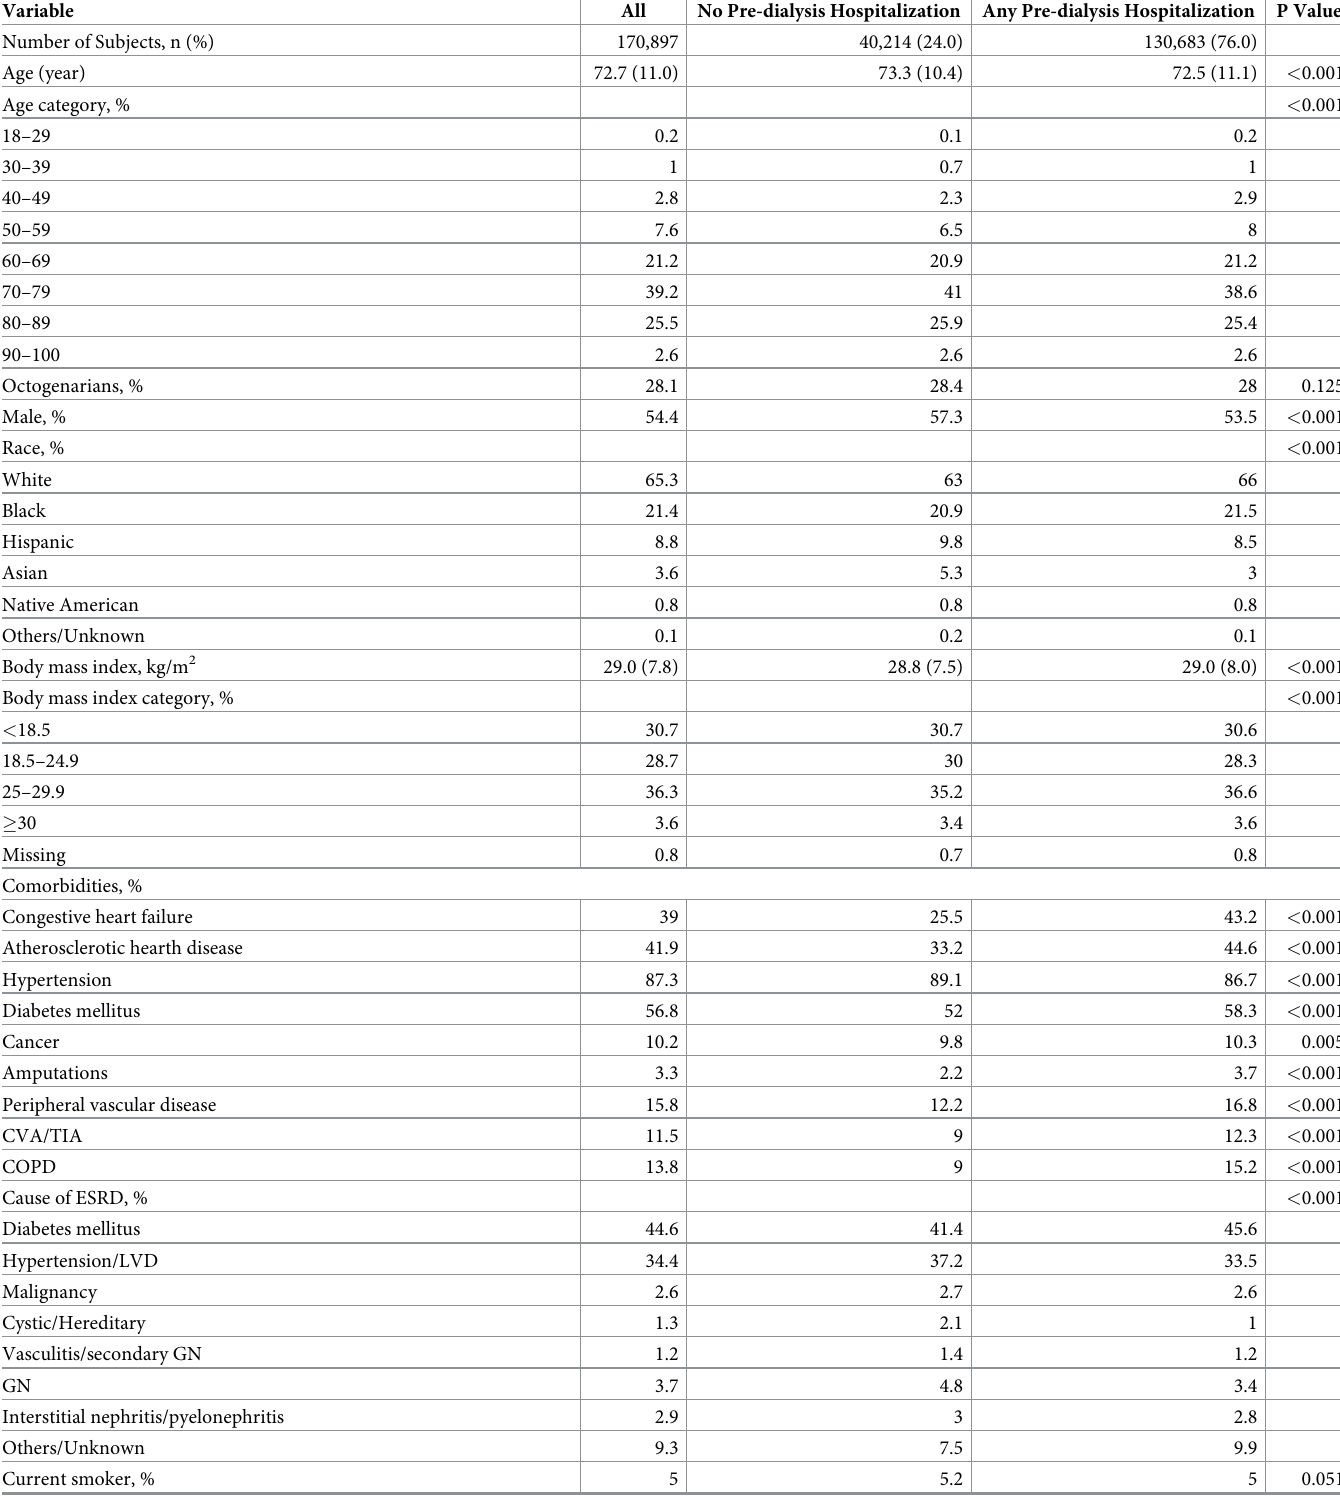
Table 1. Baseline characteristics of the study cohort stratified by presence and absence of pre-dialysis